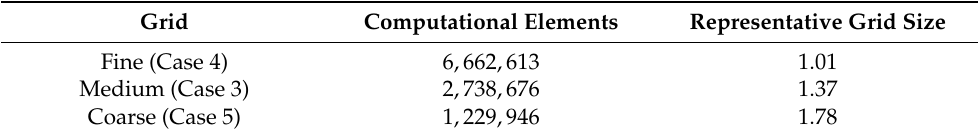
Table 7. Computational elements used in the grid independence study performed on the base immersed cooling case.